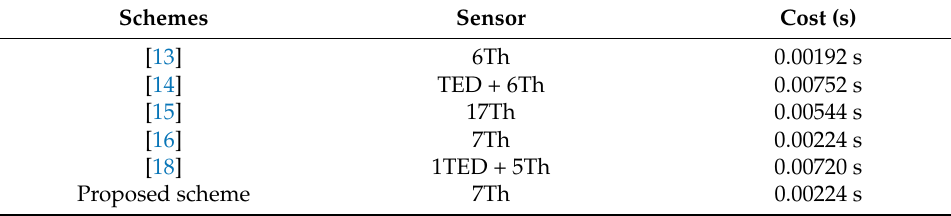
Table 13. Total running time in sensor node.